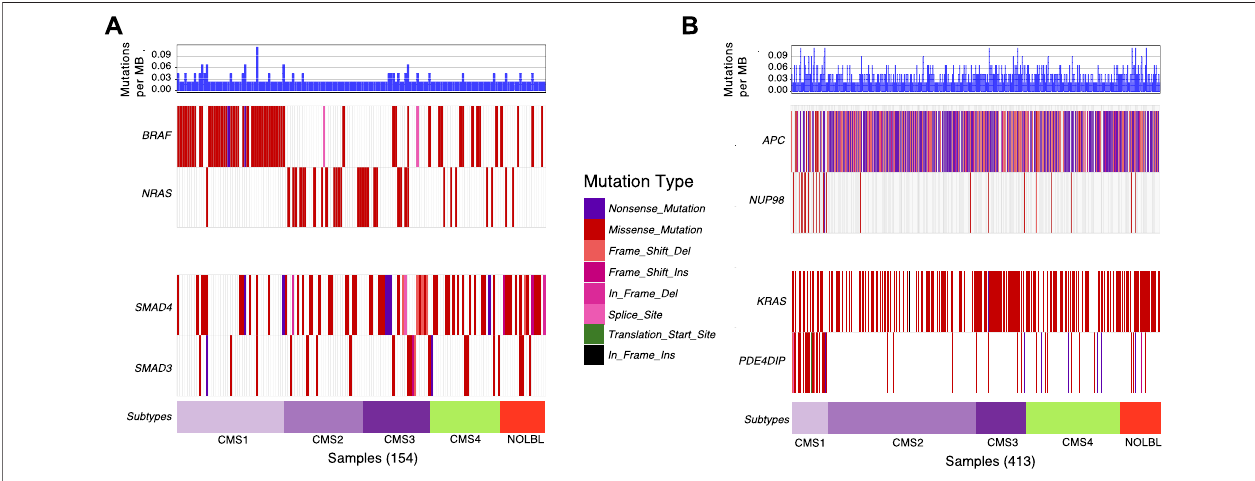
FIGURE 2 | Waterfall plots of the distribution of mutations for selected gene pairs. (A) Mutation distribution of two selected gene pairs (BRAF-NRAS and SMAD4- SMAD3)thatarefoundtobesigni fi cantlymutuallyexclusivebasedonbothDISCOVERand DISCOVER-Strat estimations. (B) Mutationdistribution oftwoselectedgene pairs (APC-NUP98and KRAS-PDE4DIP) that are found tobe signi fi cantlymutuallyexclusivebased on DISCOVER but not based on DISCOVER-Strat.Note that theset of samples included in each plot is determined by fi nding the set of patients that have a mutation in at least one of the listed genes. GenVisR R package is used to generate the waterfall plots (Skidmore et al., 2016). Subtype information is downloaded from (Guinney et al., 2015).